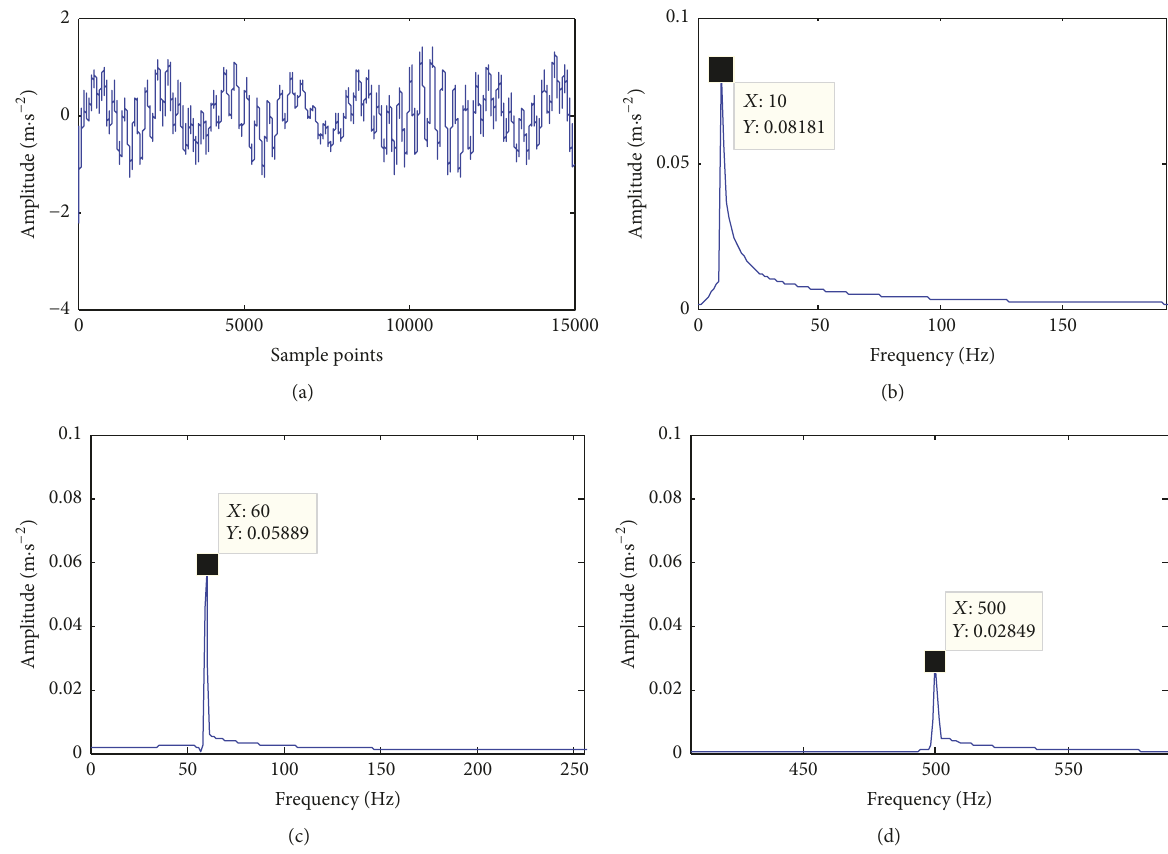
Figure 11: (a) The synthesized signal by AMD method and (b–d) the three IMFs of simulated signal with VMD decomposition.